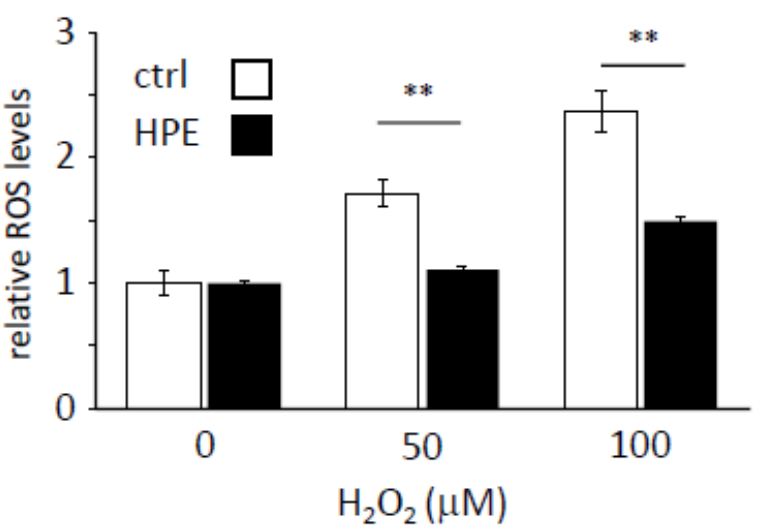
Figure 2. HPE treatment increases the ROS scavenging potential. Cellular reactive oxygen species (ROS) levels were measured under the indicated H 2 O 2 -treated conditions with or without human placental extract (HPE). The ROS level under the control condition, without HPE, was set to 1. Sample numbers were 3–4 in each condition. ** p < 0.01 by Student’s two-tailed t -test.